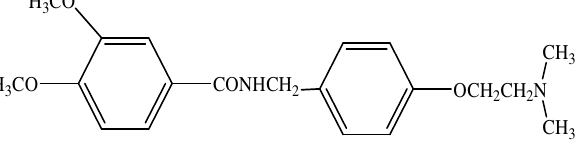
Figure 2. Structure of itopride